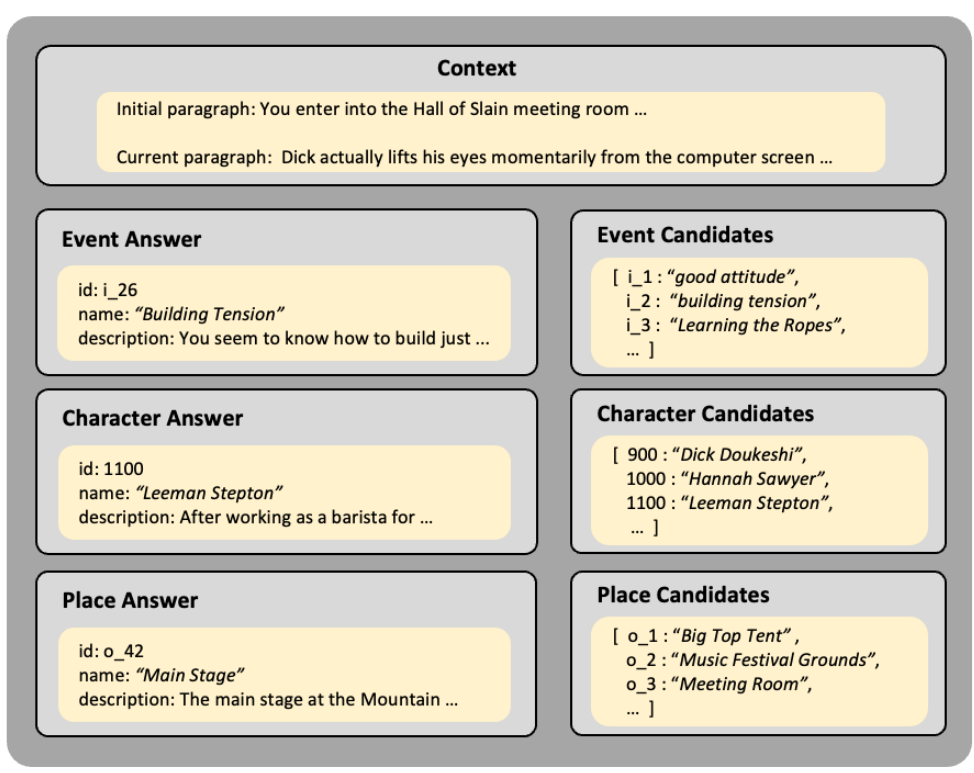
Figure 5. A dataset example to train storyline guidance model with MCQA